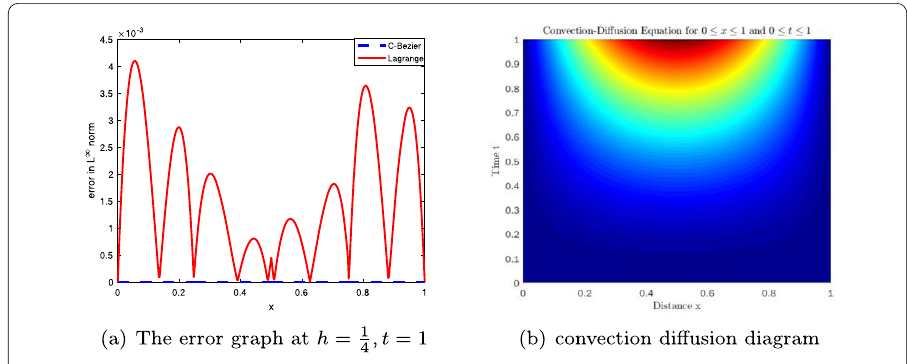
Figure 6 The error graph and convection diffusion diagram